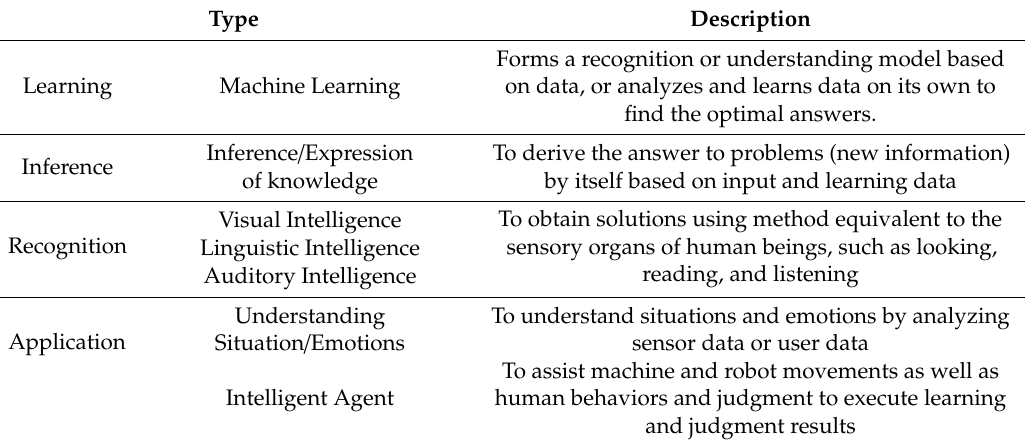
Table 1. Classification of the artificial intelligence (AI) technology.